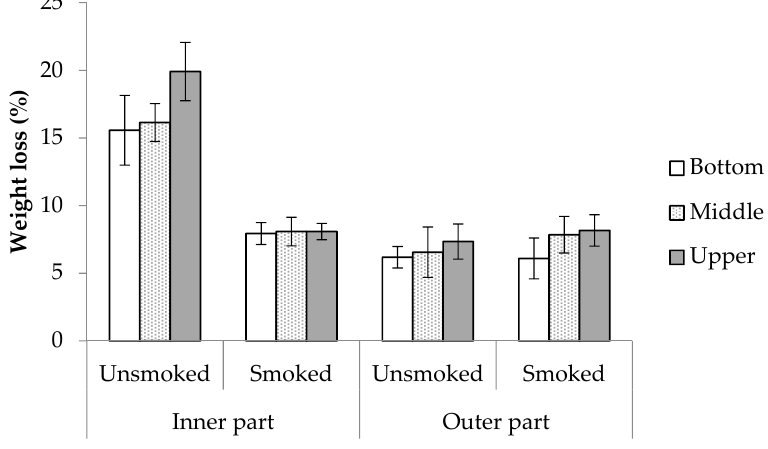
Figure 6. Wood weight loss after 12 weeks exposed to dry-wood